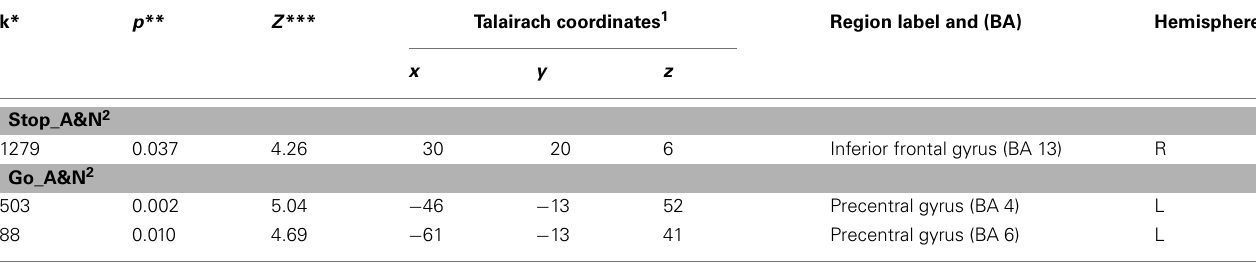
Table 6 |Activation in the stop-signal paradigm across conditions.